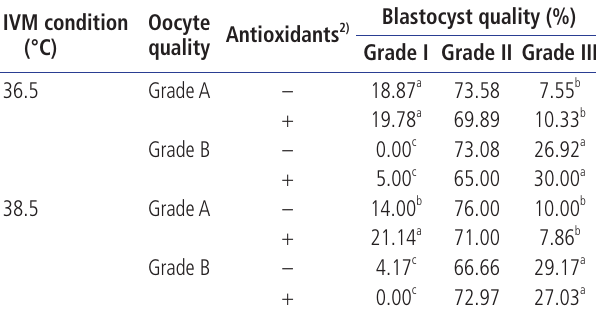
Table 6. Kendall’s Tau correlation coefficients (95% confidence intervals) between diameter, development stages (early, mid, and expanded) and